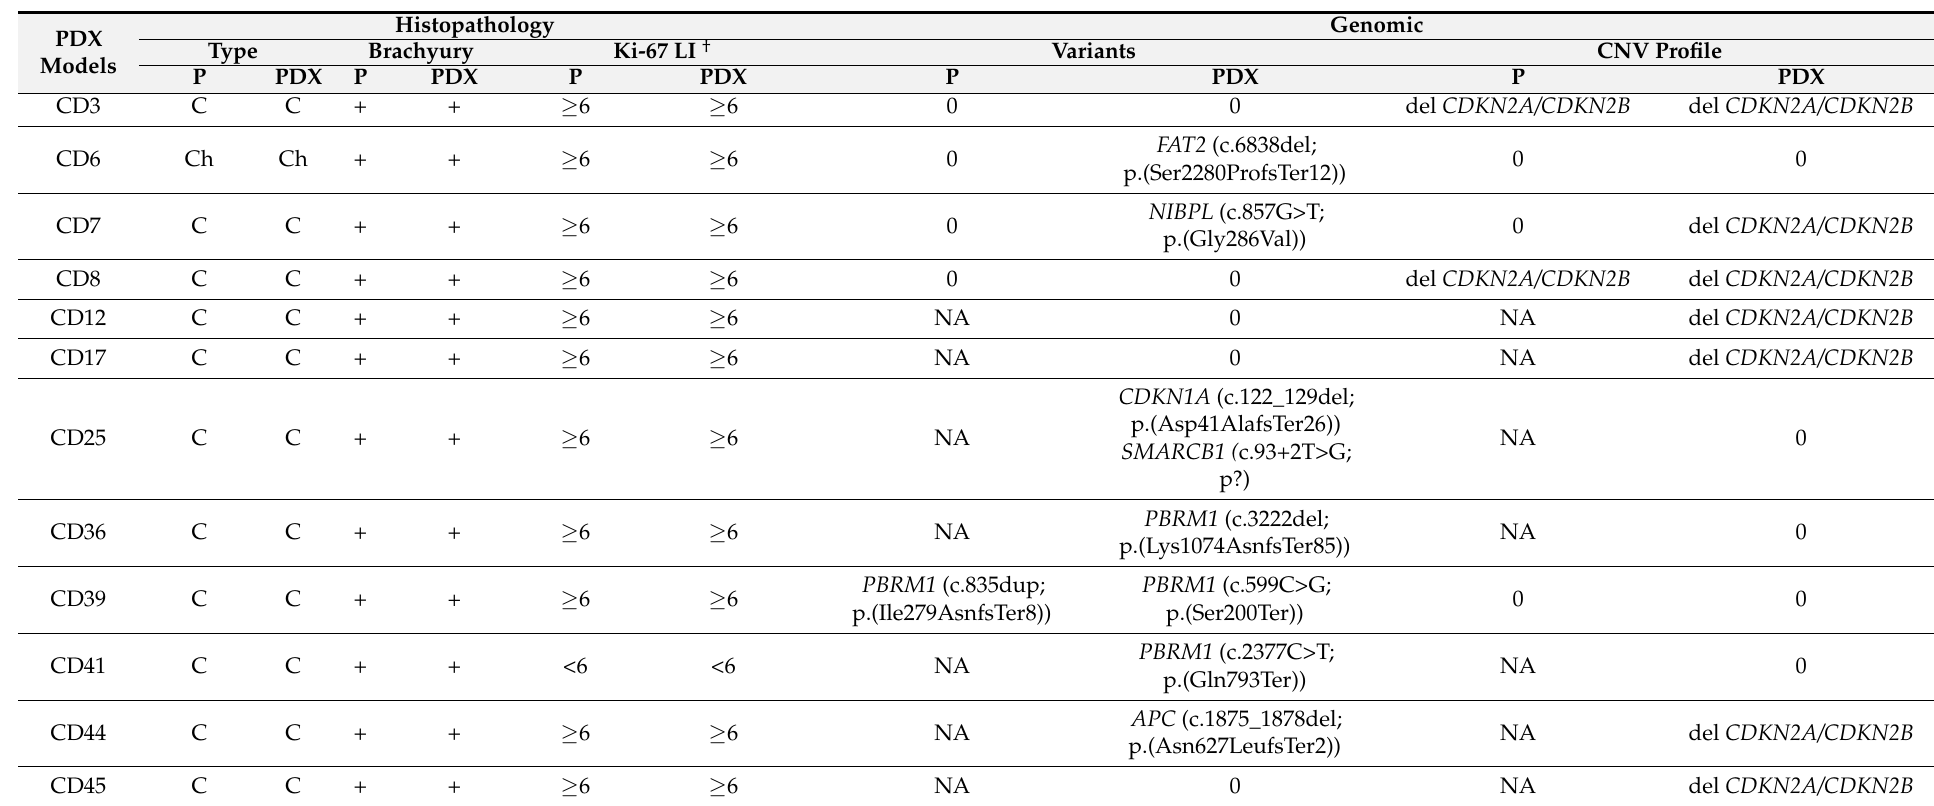
Table 2. Histopathologic and genomic comparison between patients’ tumors and the corresponding xenografts. Histopathology Genomic